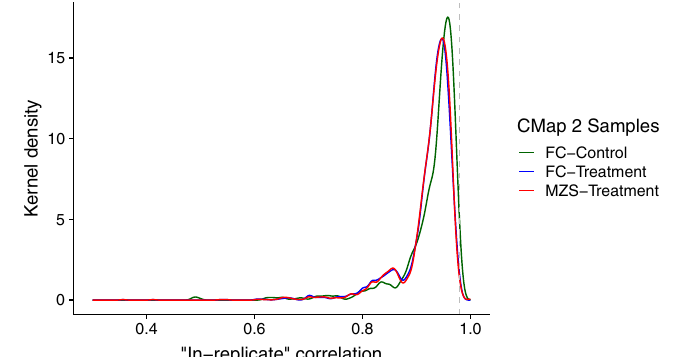
Figure 5. Distribution of rank correlations of “in-replicate” sample gene expression for the DE replicate pairs used in Fig. 3, calculated using all genes. The number of unique conditions/pairs assessed for CMap 2-FC and CMap 2-MZS are 2416 and 2477 respectively. The dotted grey line indicates the typical median rank correlation of sample gene expression for intra-platform cross-laboratory comparisons reported in Chen et al. (2007, r s =